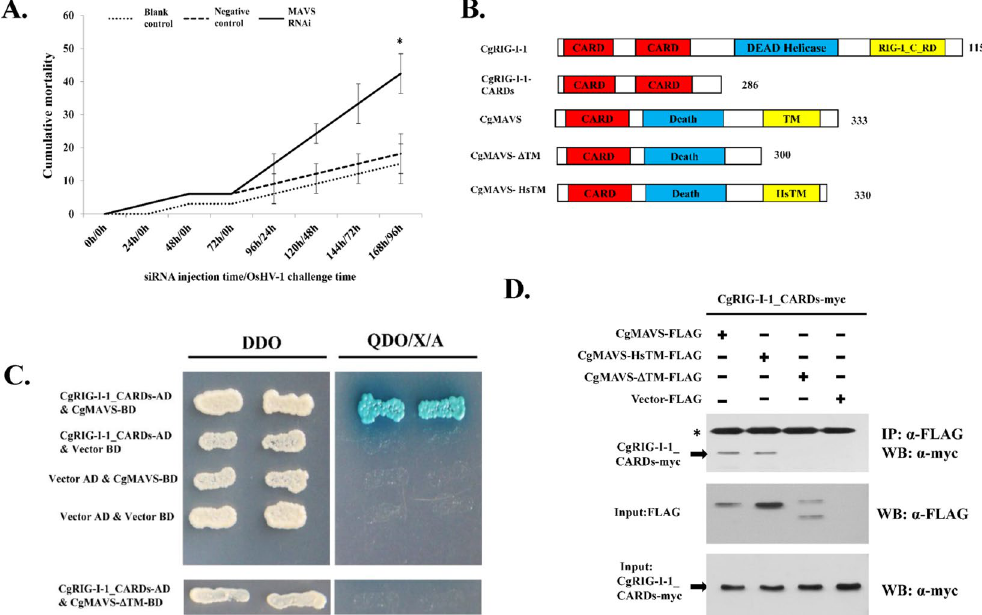
Figure 4. CgMAVS is involved in the antiviral immunity of the oyster and interacts with the CARD domains of CgRIG-I-1. ( A ) RNA interference of CgMAVS led to increased sensitivity of oysters to OsHV-1 infection. Healthy oysters were injected with PBS (control), CgMAVS-, or GFP-siRNA (negative control) and 72 h later challenged with 10 6 OsHV-1 virus particles and cumulative mortality recorded every 24 h after virus challenge. ( B ) Names and schematic representations of the full-length and truncated proteins used in this study. HsTM: transmembrane domain of human MAVS. ( C and D ) Interaction between CgMAVS and CgRIG-I-1 was detected by yeast two hybrid (Y2H) ( C ) and co-immunoprecipitation (Co-IP) ( D ) assays. DDO: -Leu/- Trp double-dropout media, QDO/X/A: -Ade/-His/-Leu/-Trp quadruple dropout media with X- α -Gal and aureobasidin. The transmembrane domain of CgMAVS is important in mediating this